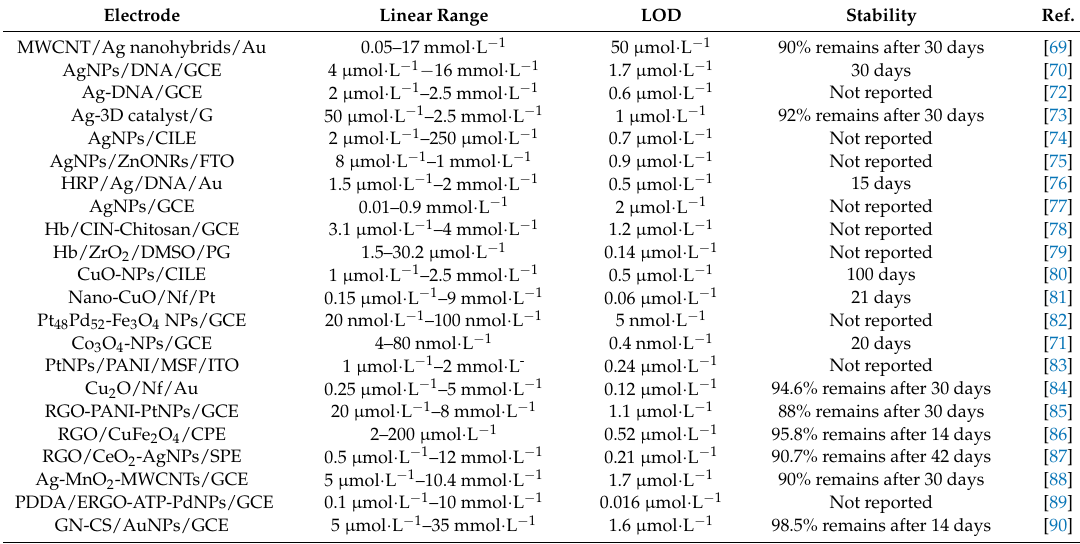
Table 3. Comparison of the electroanalytical performance of different H 2 O 2 nanosensors. Electrode Linear Range LOD Stability